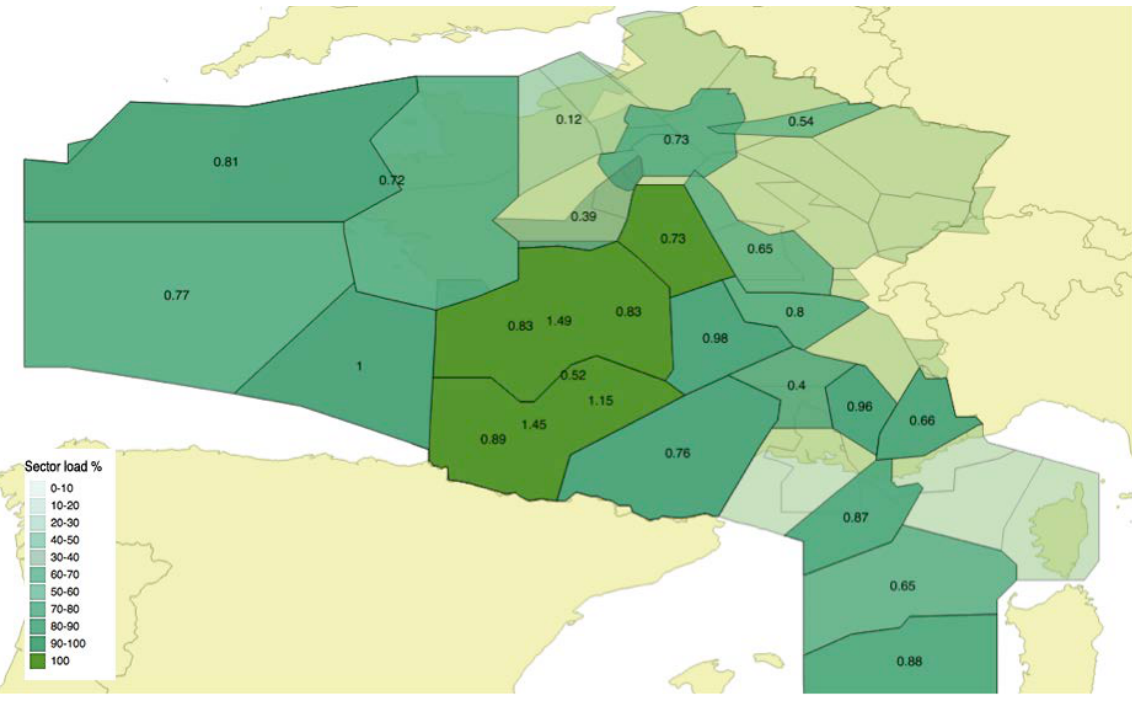
Figure 1. Load on capacitated active sectors at 10:00 on 12th September 2014 (historical data). Sectors with a darker colour have a higher